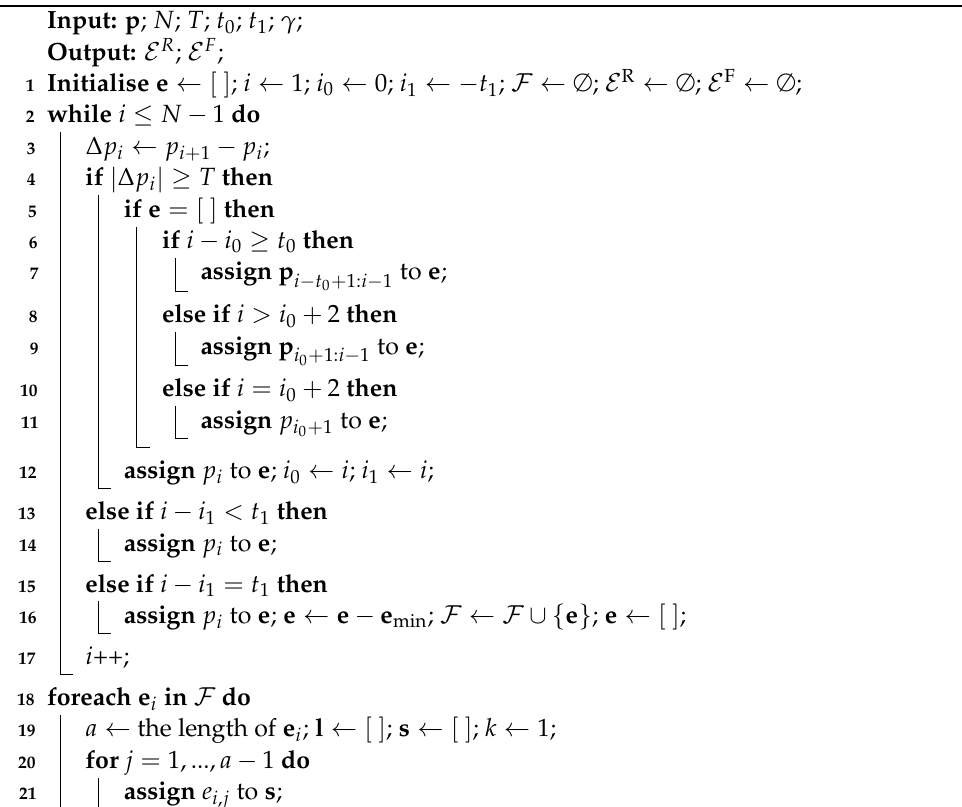
Algorithm 2: STS extraction